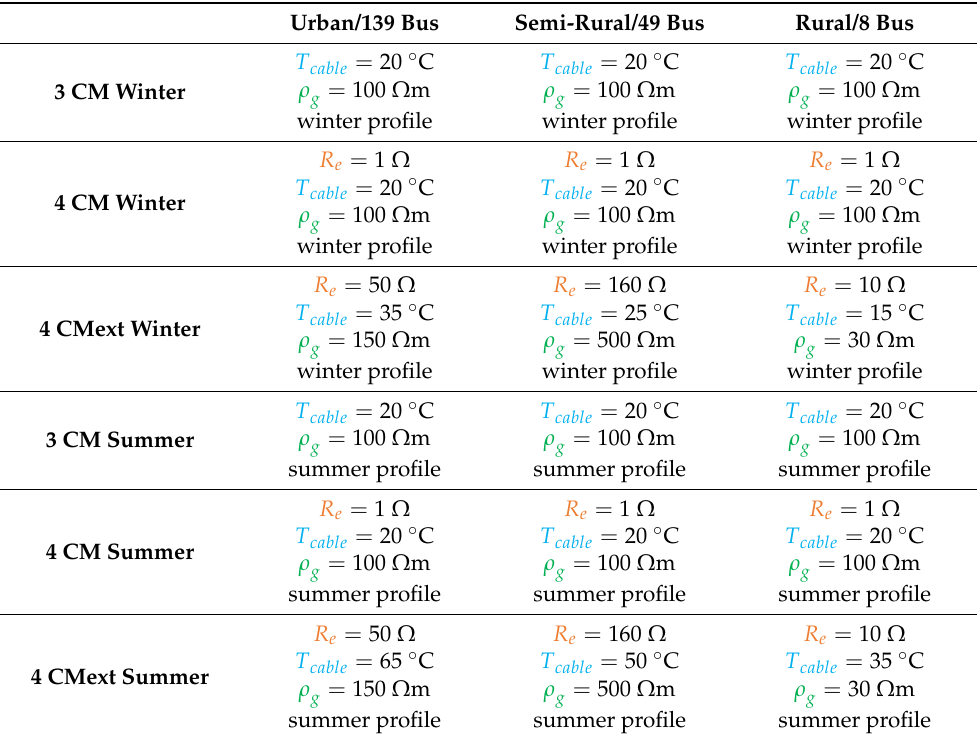
Table 10. Values of external parameters for all networks and cases.